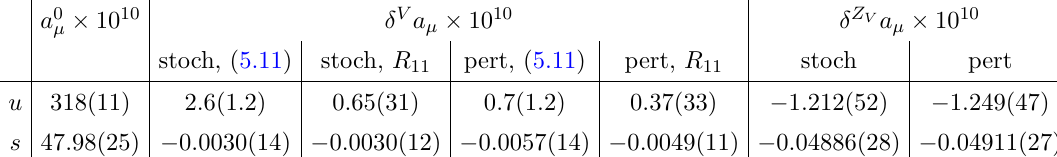
(cid:22) with an isospin symmetric pion